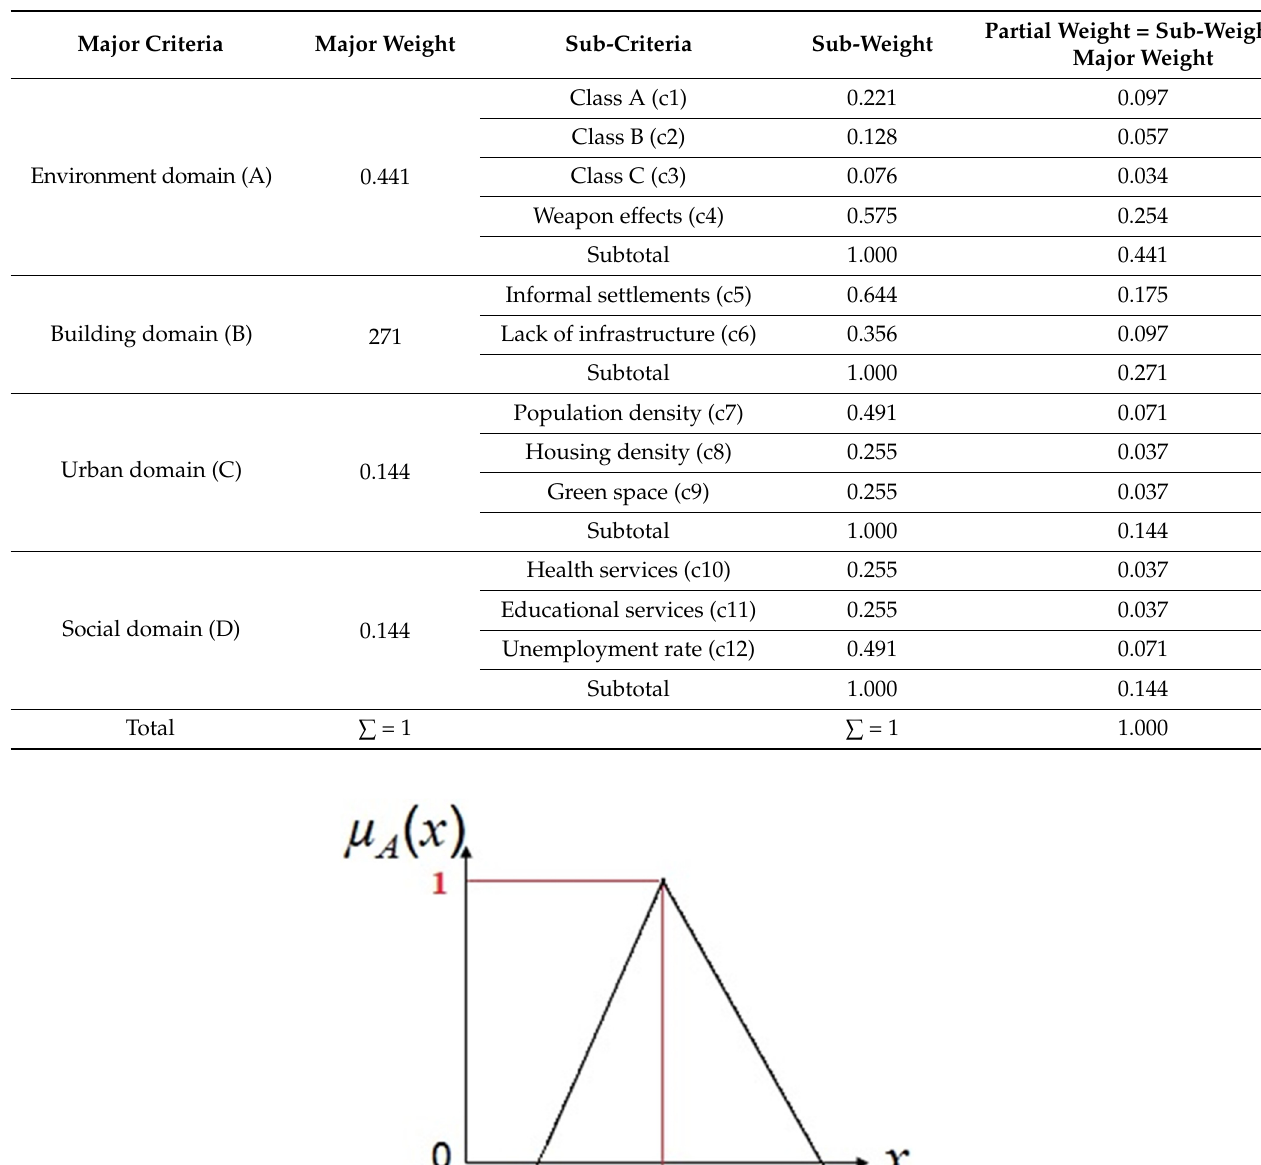
Table 6. Results of the FAHP method.